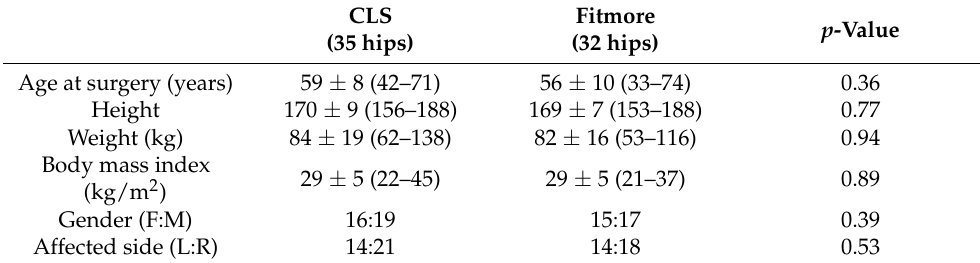
Table 1. Patient